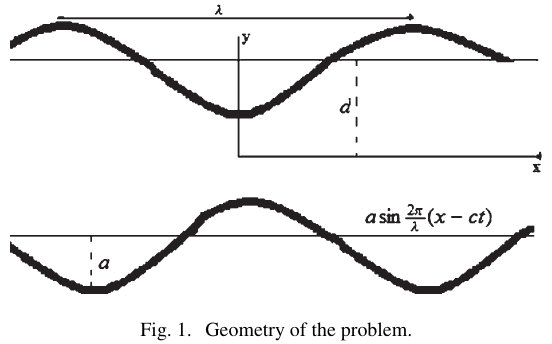
Fig. 1. Geometry of the